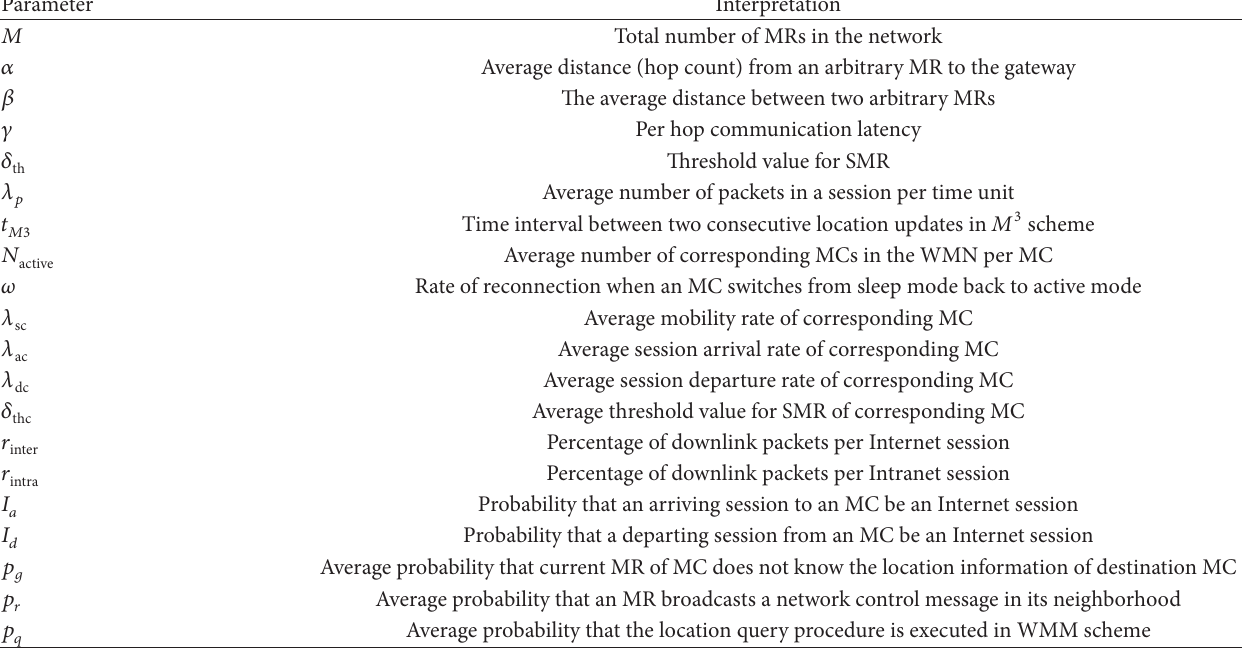
Table 1: Parameters and their interpretations for mathematical modeling and analysis.